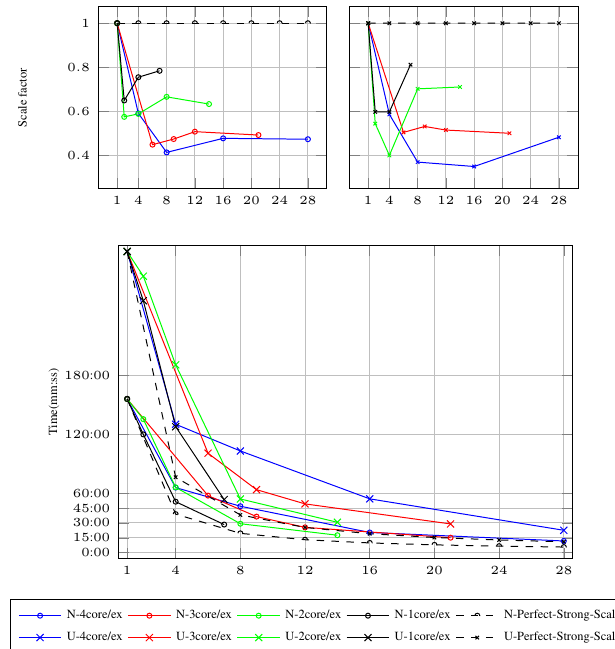
Figure 6. Scaling on processing and persisting the DT according to the number of cores with 4,3 and 2 cores/executors(12Go Ram/executors) on a 300 millions of points test set generated with the normal(N) and uniform(U) random distribution. The two first figures show the scale factor according to the number of core, last figure the